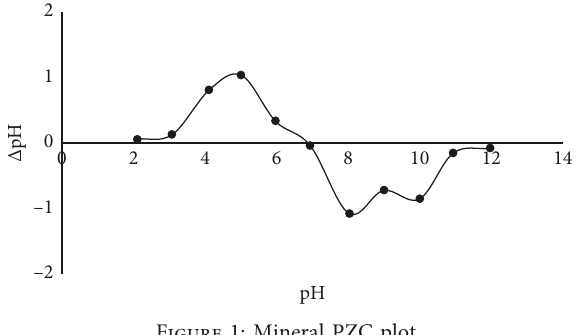
Figure 1: Mineral PZC